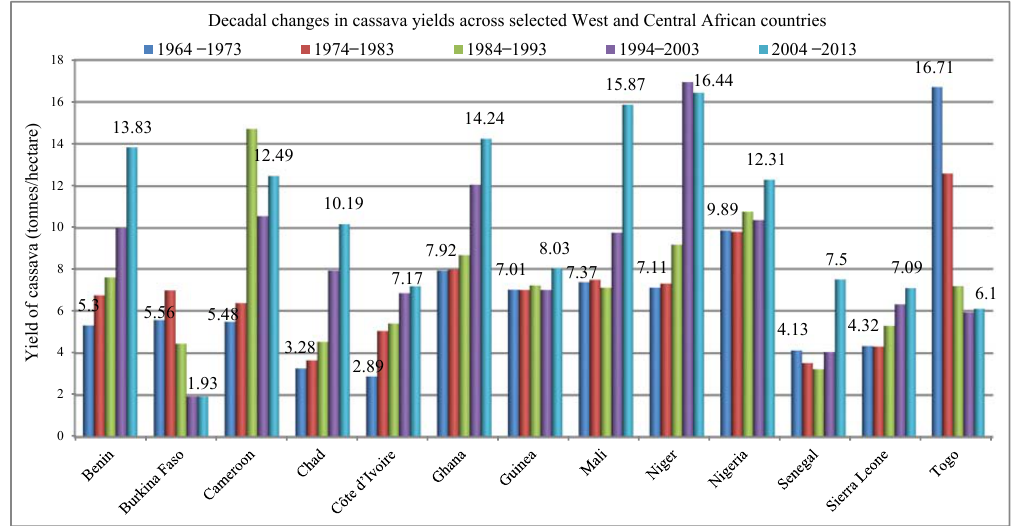
Figure 1. Decadal changes in cassava yields across selected West and Central African countries. Source: Author’s construct with data from FAOSTAT (2014). Annual growth rates for the period 1964–2013: Benin (2.34% ***), Burkina Faso ( − 3.43%, ***), Cameroon (2.08%, ***), Chad (3.00%, ***), Côte d’Ivoire (2.14%, ***), Ghana (1.61%, ***), Guinea (0.27%, ***), Mali (1.75%, ***), Niger (2.50%, ***), Nigeria (0.49%, ****), Senegal (1.28%, ***), Sierra Leone (1.42%, ***), Togo ( − 2.60%, ***).